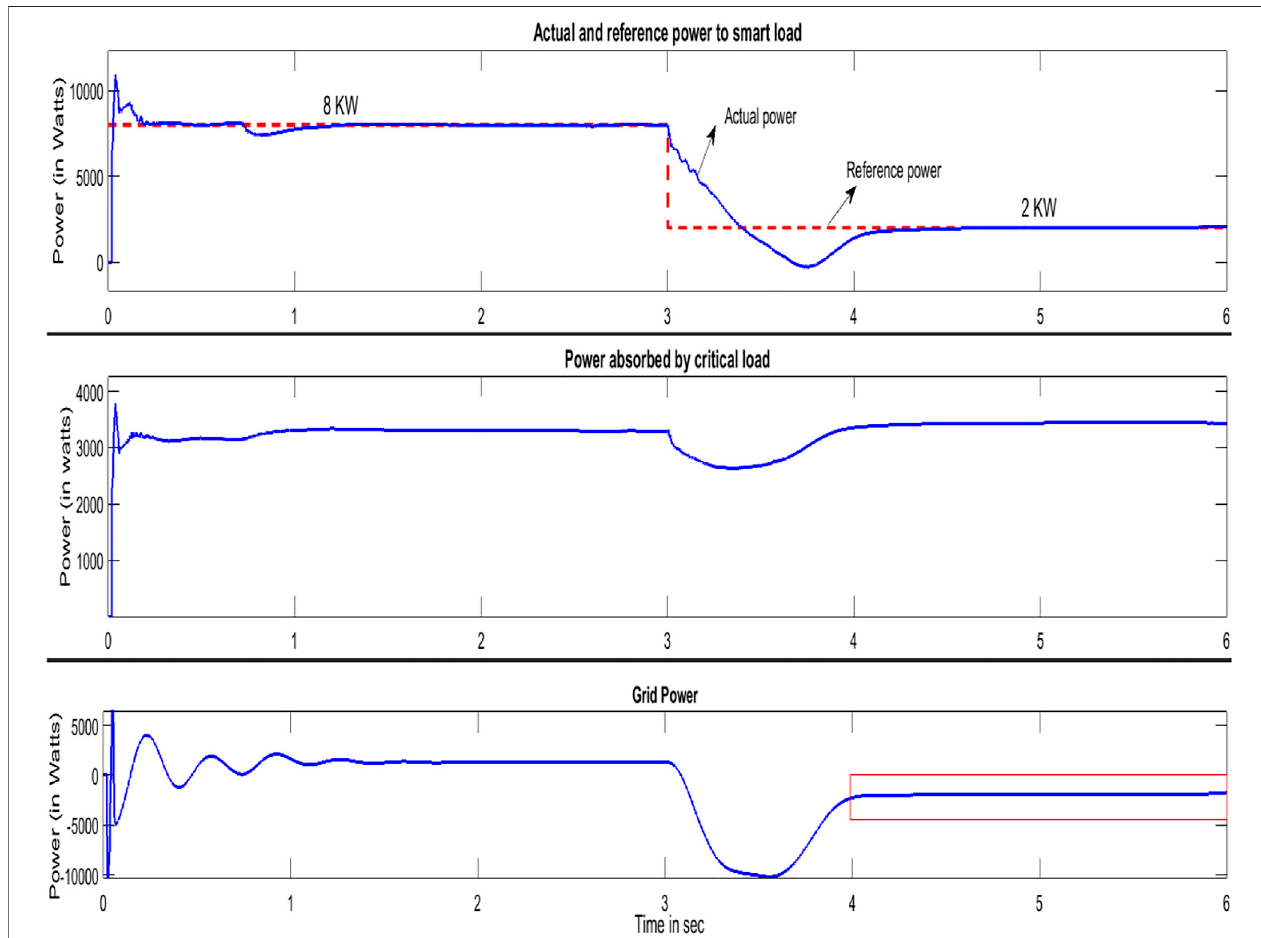
FIGURE 7 | Power variations for step change in reference